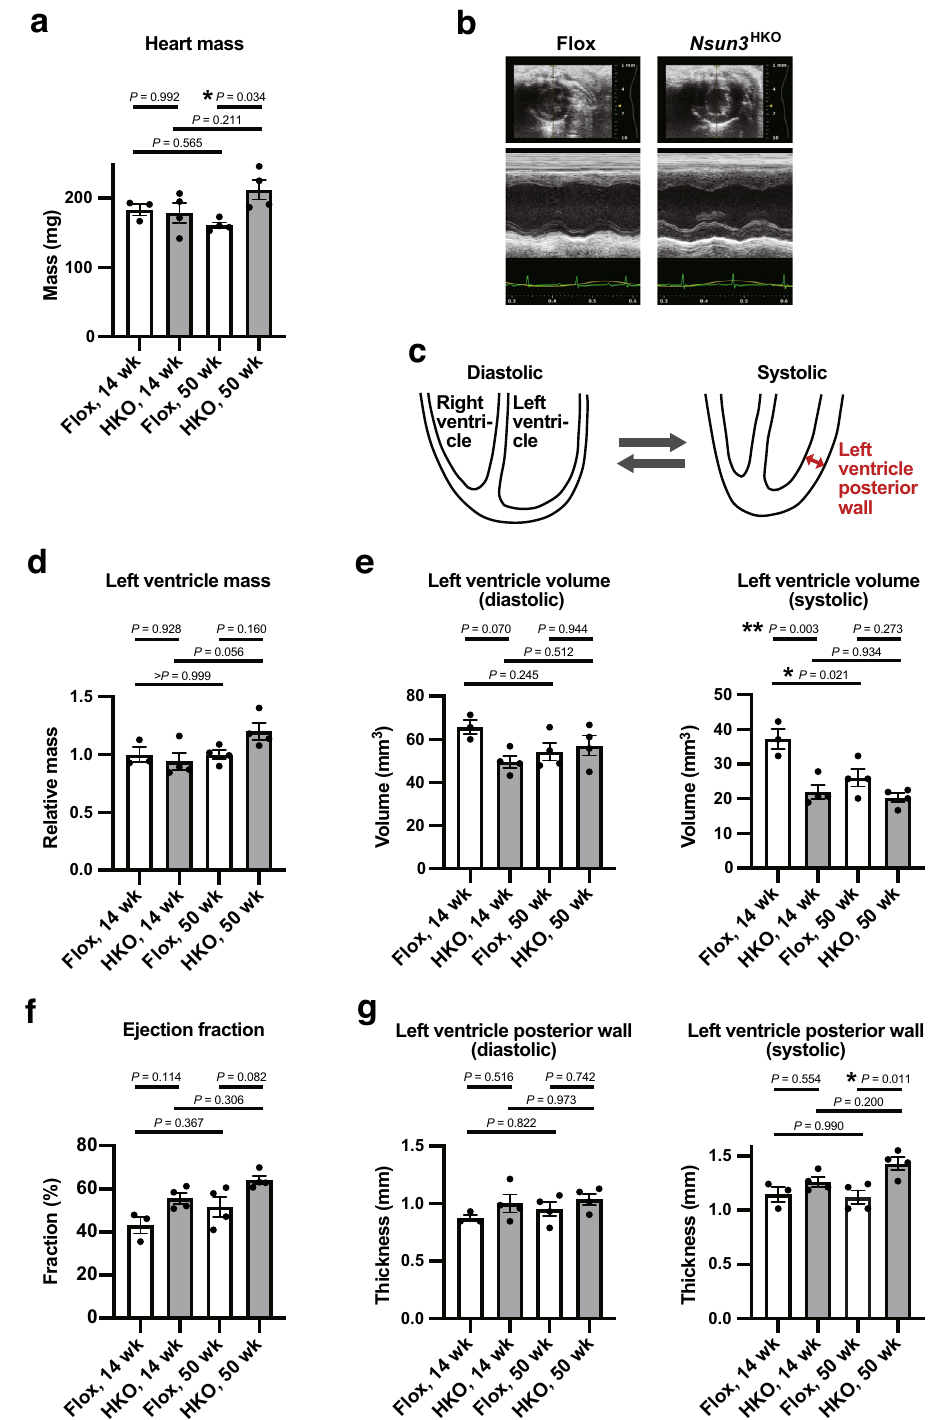
Fig. 3 Heart aberrations in Nsun3 HKO mice. a The mass of 14- and 50-week-old mice hearts that were dissected and measured after echocardiography. b Representative M-mode echocardiography images of 50-week-old Flox mice and Nsun3 HKO mice. The upper images show the axis view of the left ventricle. Lower panels show the M-mode tracing of the left ventricle. c Schematic of diastolic stage and systolic stage of heart. d Left ventricle relative mass estimated by the echocardiography image analysis. e Left ventricle volume at diastolic stage (left panel) and systolic stage (right panel). f Calculated ejection fraction (%) of the hearts. g Left ventricle posterior wall thickness at diastolic stage (left panel) and systolic stage (right panel). Means ± s.e.m. from n = 3 mice (14-week-old Flox) or 4 mice (14-week-old Nsun3 HKO , 50-week-old Flox and Nsun3 HKO mice). ** P < 0.01 and * P < 0.05 by two-way ANOVA followed by Tukey ’ s